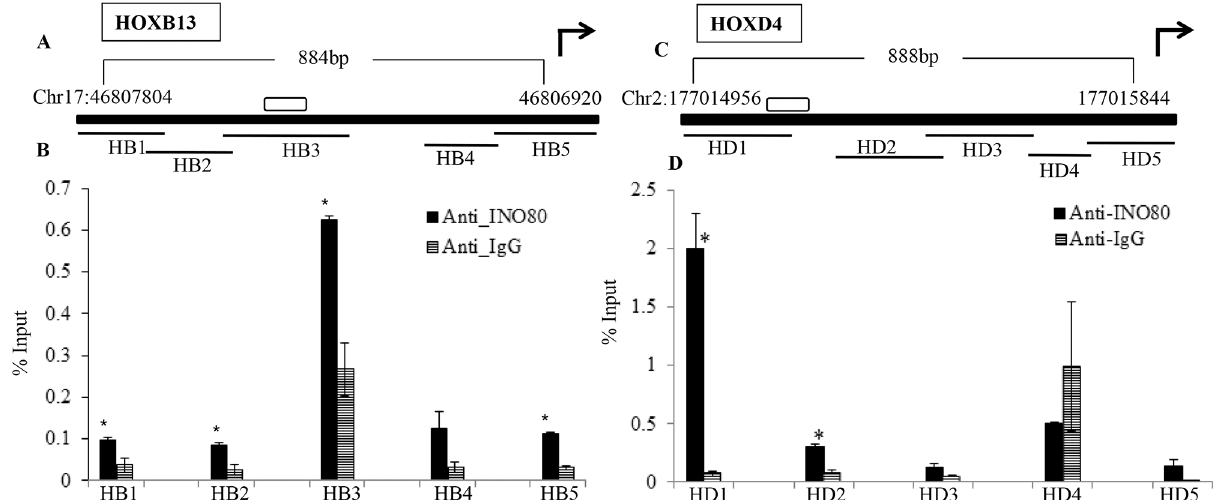
Fig 8. In vivo localization of INO80 in the upstream regions of its target genes. The data from ChIP followed by qPCR for HOXB13 (A & B) and HOXD4 (C & D) are shown. A & C- Line diagram indicating the upstream region analysed by qPCR of ChIP DNA as thick black line mapping on chromosome17 and 2 for HoxB13 and HoxD4 respectively along with the genomic positions, the bent arrow indicates the direction of transcription of the gene, unfilled box is the hINO80 binding motif present in the upstream region. HB1-HB5 and HD1-5 are the amplicons originating from the upstream region covering 884bp and 888bp of HoxB13 and HoxD4 respectively using primers listed (S2B Table). B&D show the enrichment as % Input for each region HB1-HB5 (B) and HD1-HD3(C), ( * p value < 0.05 and ** p < 0.001 in comparison with IgG for each primer